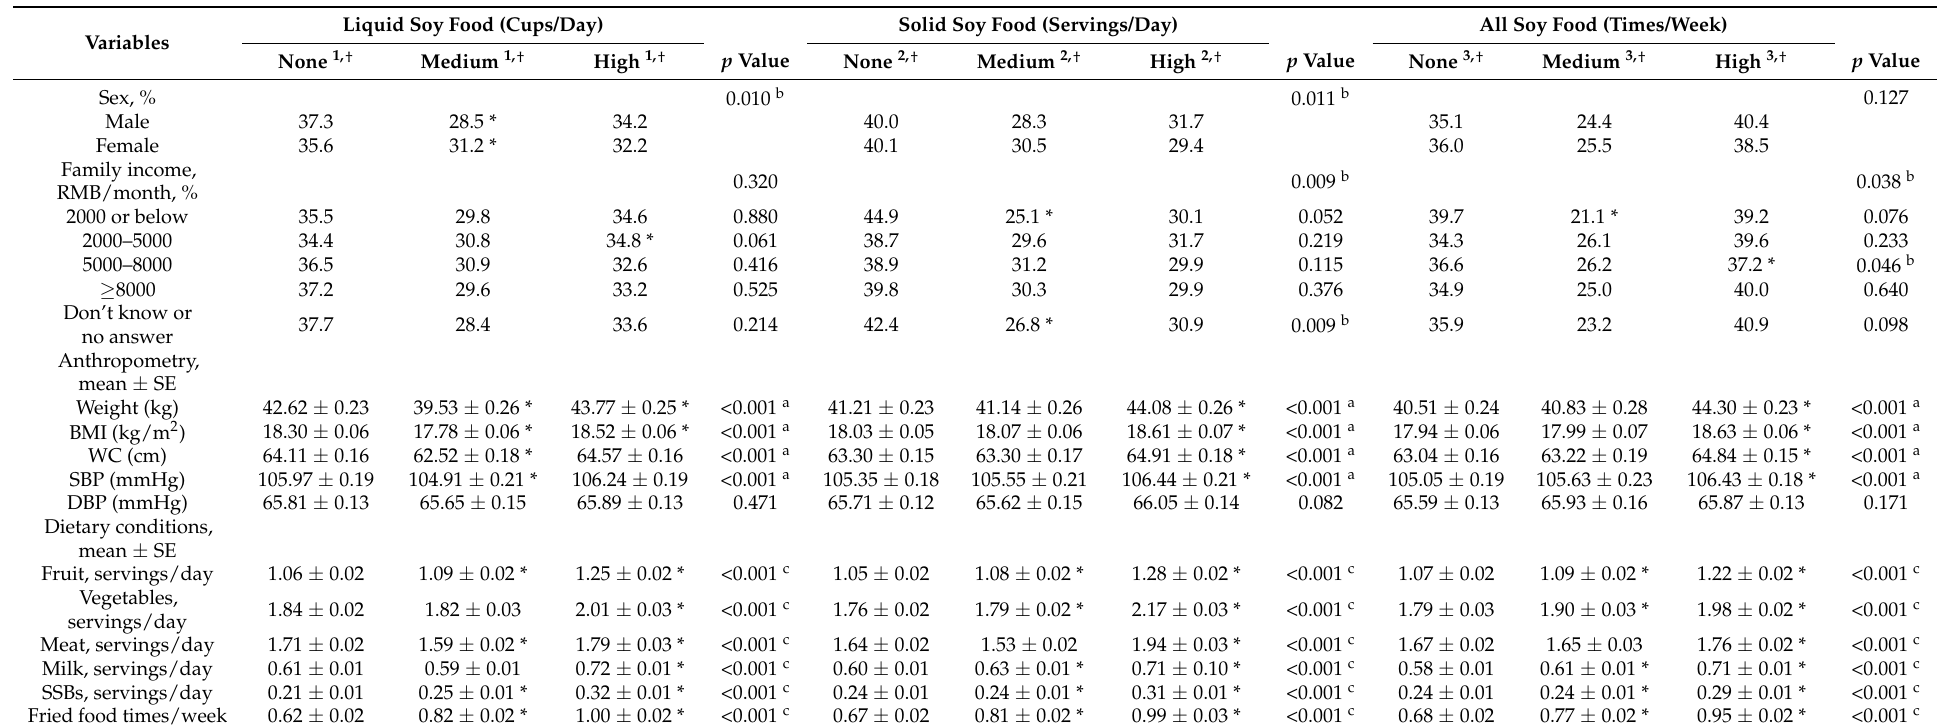
Table 2. Characteristics of participants stratified by soy food intake